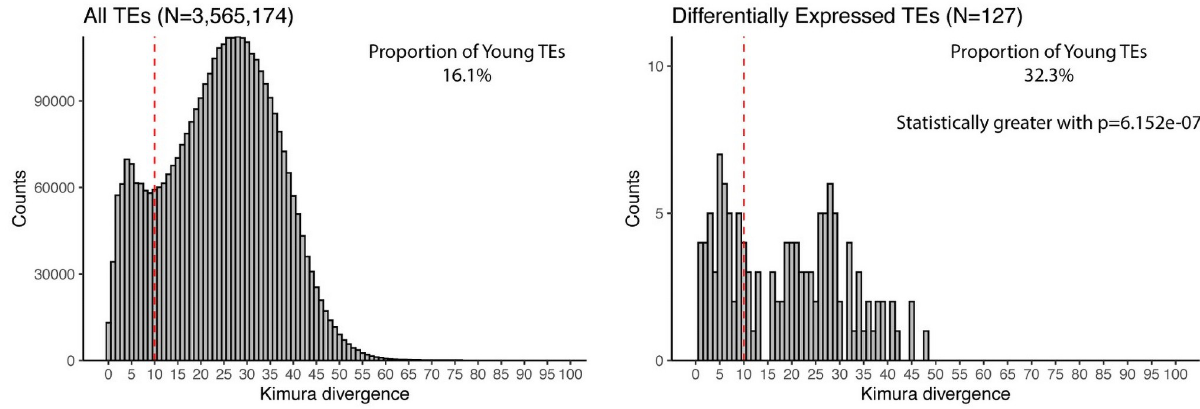
Fig 2. Kimura divergence histograms for Mus musculus TEs. “All TEs” (left) correspond to all TEs in the Mus musculus genome (“All TEs”, left), and DE-TEs (right) to the Differentially Expressed TEs. Dashed line at 10% correspond to the threshold to label TEs as young ( � 10%) or old ( > 10%). The proportion of young TEs in each group is shown at the upper right corner of the respective